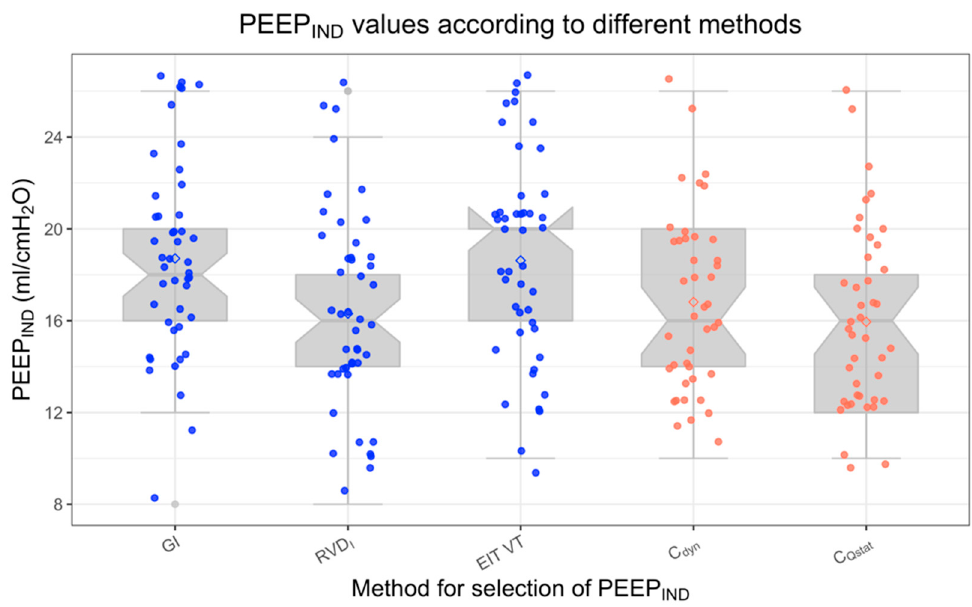
Figure 2. PEEP IND values according to different methods for identification of PEEP IND . Median PEEP values did not differ between the RVD I method and quasi-static compliance measured during the inspiratory limb of the LFM. However, median PEEP IND values according to the minimal Global Inhomogeneity Index (GI) were around 2 cm H 2 O higher than according to the other methods. Table 2. Comparison of different methods for PEEP IND determination during a decremental PEEP trial compared to the regional ventilation delay index method (RVDI) using Electrical Impedance Tomography (EIT); data are shown as mean with 95% CI or number (percent). * p <